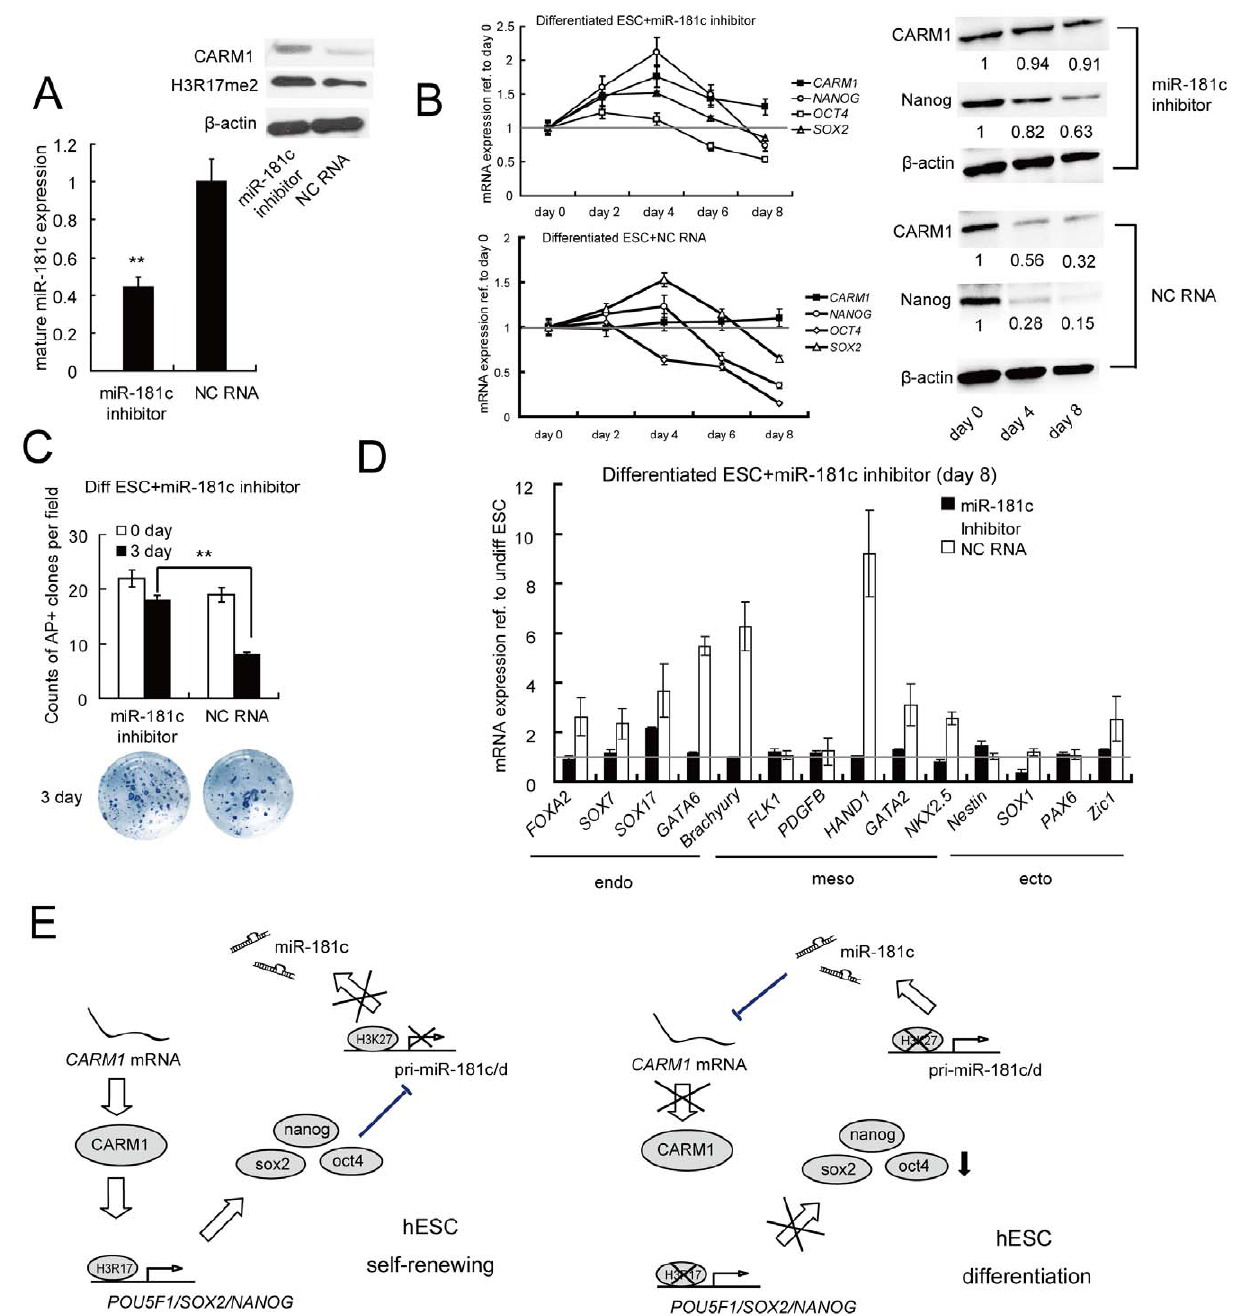
Figure 4. The miR-181c inhibitor suppresses hESC differentiation. (A) Enforced expression of the miR-181c inhibitor down-regulated mature miR-181c levels relative to negative control (NC) RNA-transfected ESCs, as shown by qRT-PCR. **, p , 0.01. Western blotting detected that CARM1 and H3R17me2 protein levels were clearly decreased. (B, C, D) The effect of miR-181c inhibition on differentiated hESCs. Human ESCs were transfected with miR-181c inhibitor or NC RNA and then induced to differentiate by the addition of BMP4 in the absence of bFGF. (B) The expression of CARM1 , Nanog , Sox2 , and Oct4 at the mRNA level was quantified by qRT-PCR, CARM1 and Nanog protein expression levels were also quantified by Western blotting. (C) Pluripotency was examined by AP staining 3 days after transfection. The counts of AP-positive clones and the images of the representative plates are shown. Samples were assayed in duplicate (n=3). **, p , 0.01. (D) Expression of a subset of differentiation-associated genes in ESCs transfected with miR-181c inhibitor or NC RNA were monitored by qRT-PCR and normalized to b -actin expression levels. Mean levels (after 8 days) expressed relative to undifferentiated hESCs (shown as one fold) are shown. (E) Model for the miR-181/CARM1/core-pluripotency-factors regulatory loop in the modulation of hESC pluripotency. Pluripotency is maintained in ESCs in part by histone H3 arginine methylation by CARM1 at the Oct4 , Nanog and Sox2 promoters. The core pluripotency factors also recruit H3K27 methylases to the miR-181c promoter to inhibit its expression. In differentiated hESCs, H3K27 methylation is inhibited due to the reduction of core pluripotency factors, and miR-181 family members are subsequently induced and down-regulate CARM1 activity. H3R17me2 production is eventually stopped, which aggravates the decrease in expression of core pluripotency factors as well as the loss of pluripotency.